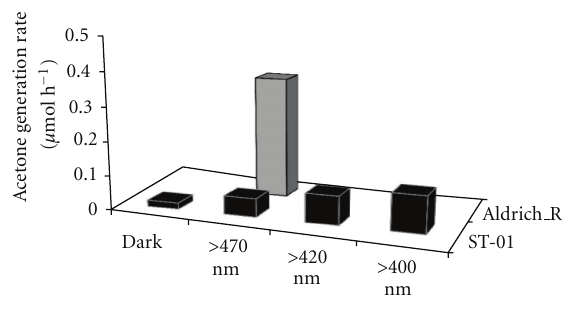
Figure 1: Comparison of rate of photocatalytic acetone generation from suspensions containing 2-propanol and Au/TiO 2 (ST-01 and Aldrich R) under vis irradiation with mercury lamp and cut-o ff filters: Y48 ( λ > 470 nm), Y43 ( λ > 420 nm), L42 ( λ > 400 nm).